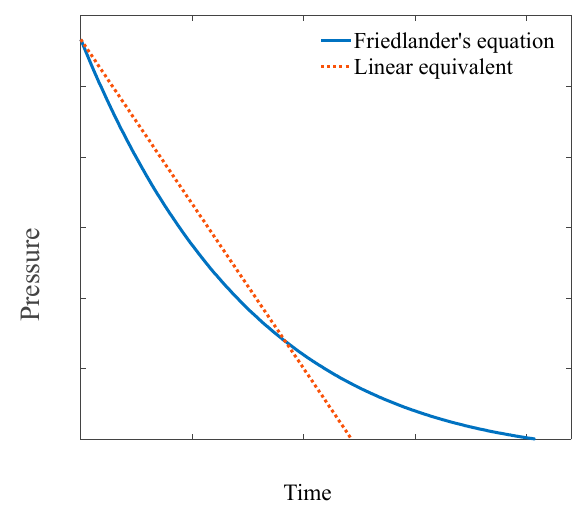
Figure 1. Blast load time-histories: exponential and triangular.